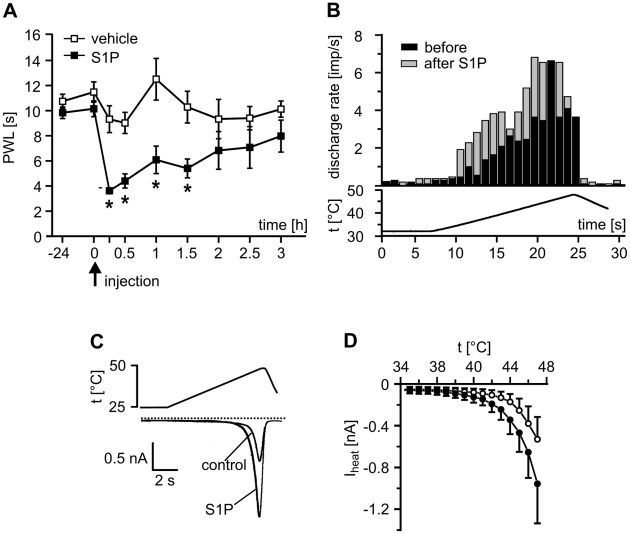
S1P-induced sensitization of heat pain behavior, nociceptor neuron discharge in vitro and heat-activated ionic currents.(A) Injection of S1P into the paw skin (5 µl of a 100 µM S1P solution in PBS) but not vehicle (n = 10, n.s.) induced a significant transient drop in paw withdrawal latencies (PWL) in response to heat stimulation from 10.15±0.63 to 3.62±0.24 s (n = 10, *p<0.05; ANOVA). Heat sensitization fully recovered to baseline within three hours. (B) Discharge activity of single primary nociceptive neurons in vitro significantly increased from 2.03±0.39 before (black columns) to 3.21±0.50 Imp/s (grey columns) after the receptive fields of the fibers were exposed to 1 µM S1P for 5 min (n = 11, p<0.05; Wilcoxon matched pairs test). (C) After conditioning stimulation with S1P, the heat-induced current of a dorsal root ganglion neuron exhibited increased peak amplitudes and was activated at a lower temperature compared with control. (D) Temperature-current plots of four neurons stimulated with a ramp-shaped heat stimulus with a linear rise of temperature from room temperature to 50°C before (open circles) and after conditioning stimulation with S1P (filled circles, threshold temperature).